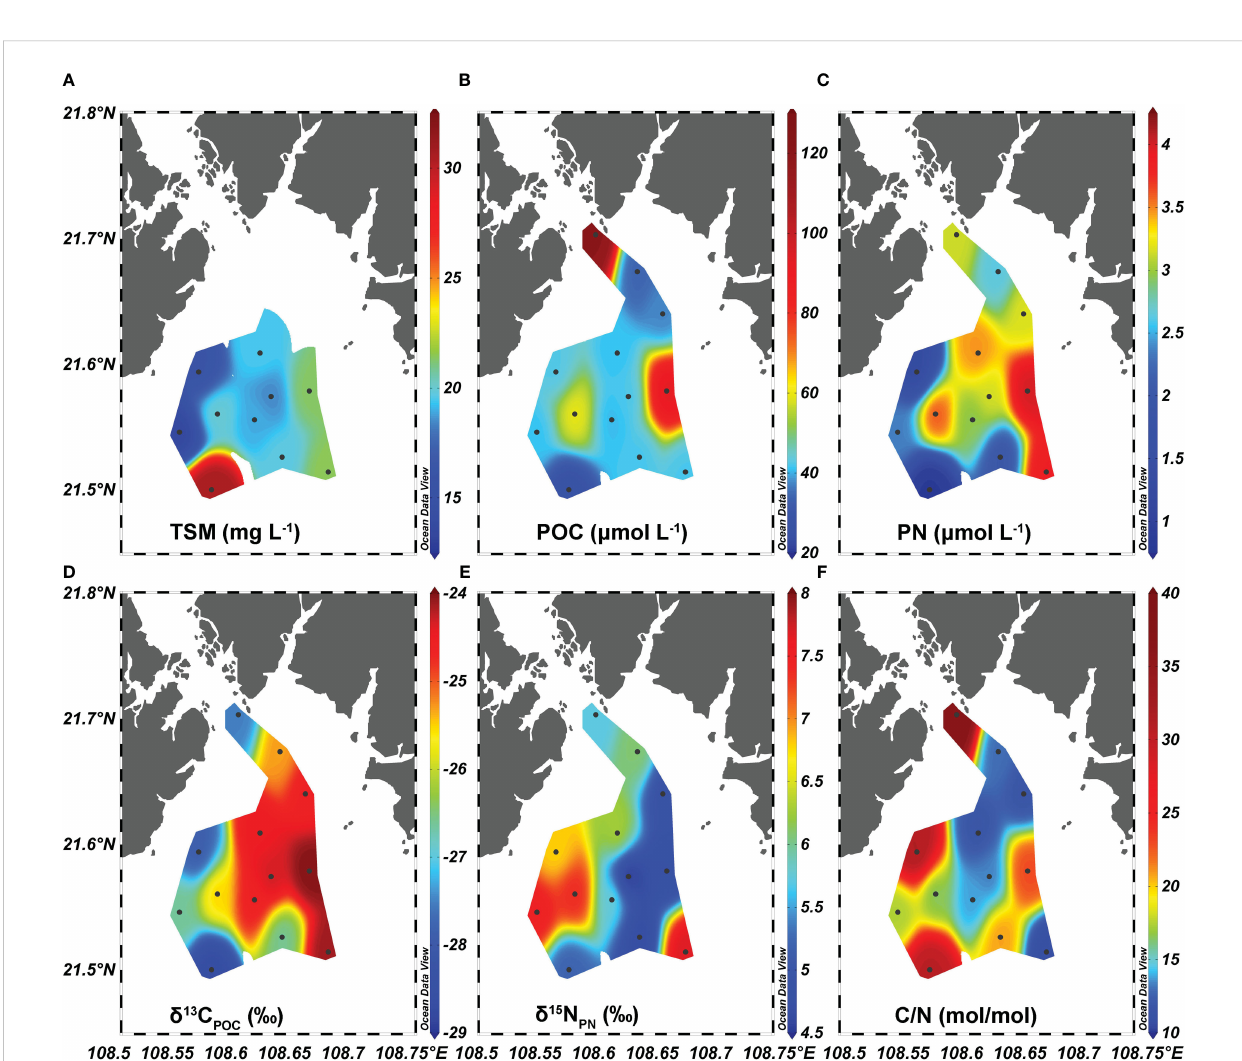
FIGURE 4 Distributions of (A) total suspended matter (TSM), (B) particulate organic carbon (POC), (C) particulate nitrogen (PN), (D) d 13 C POC , (E) d 15 N PN , and (F) C/N ratio in the surface water of Qinzhou Bay.